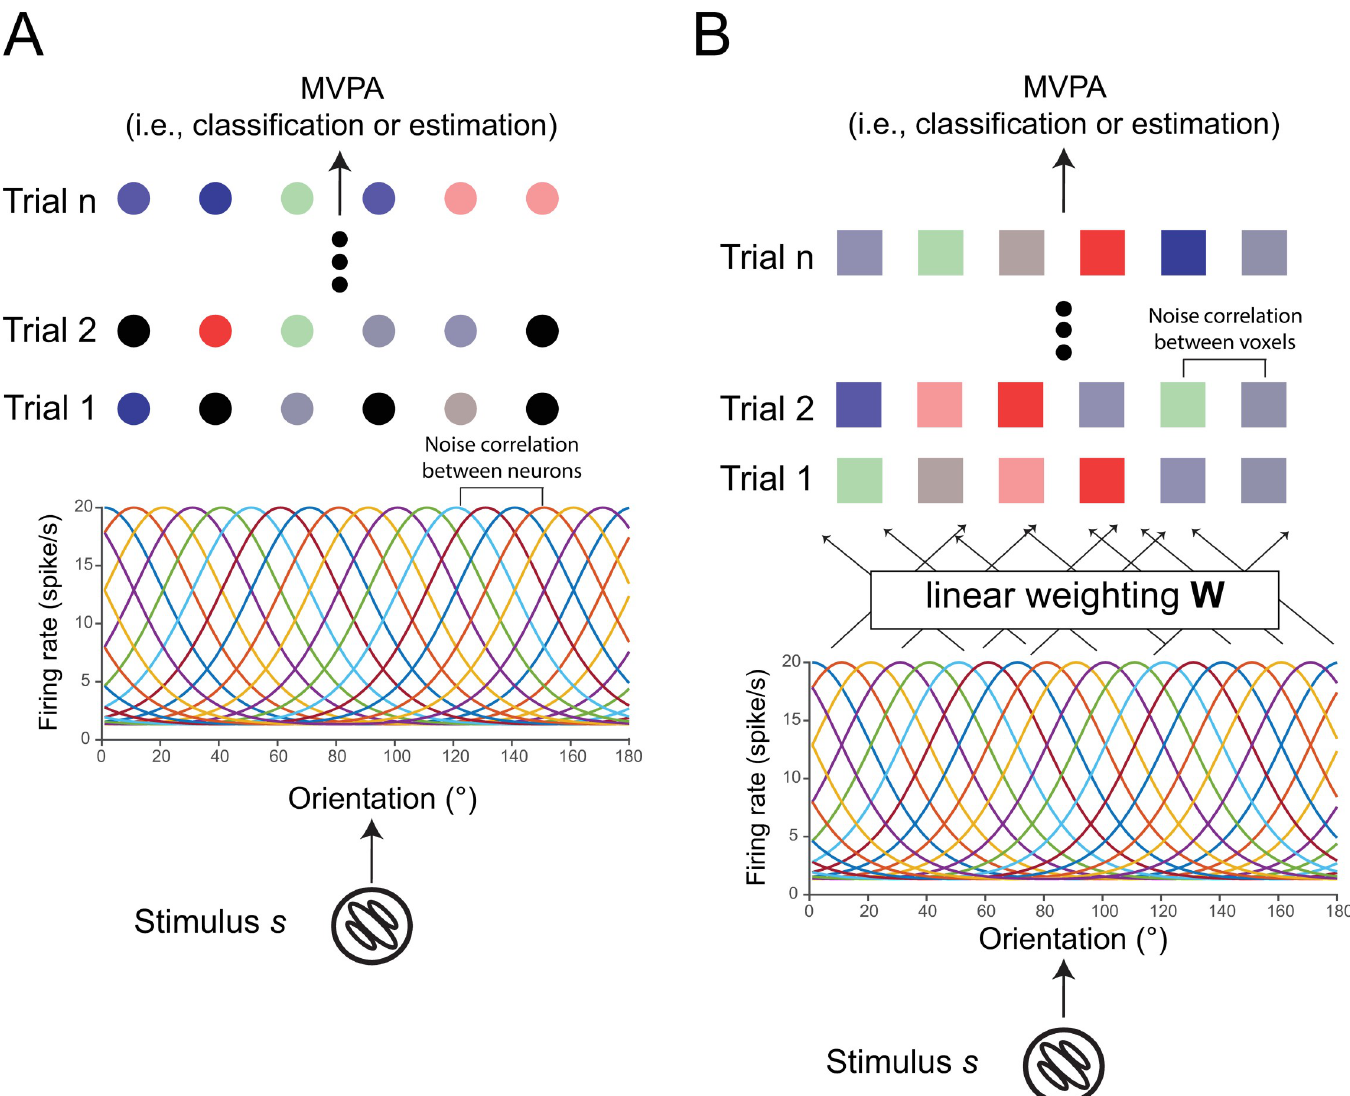
Fig 2. Neuron- and voxel-encoding models. The neuron-encoding model (panel A) proposes a neuronal population with orientation-selective tuning curves. Each neuron has Poisson-like response variance and the noise correlation between two neurons can be specified with different structures and strength (see Materials and Methods). The voxel-encoding model proposes a similar neuronal population and the response of a single voxel is the linear combination of the responses of multiple neurons. The noise correlation between two voxels can be specified using similar methods (see Materials and Methods). Note that voxelwise NCs can come from the response variability at both neuronal and voxel levels (see Fig 6). Using the neuron- and the voxel-encoding models, we can generate many trials of neuronal and voxel population responses and perform conventional MVPA on the simulated data. The goal is to examine multivariate decoding performance as a function of the NC structure and strength between either neurons or